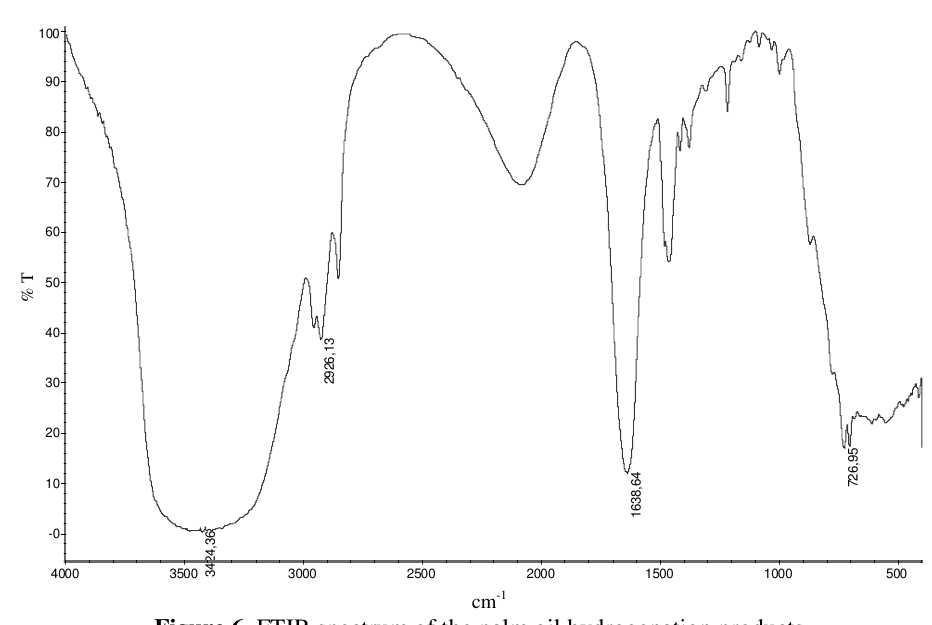
Figure 6. FTIR spectrum of the palm oil hydrogenation products.